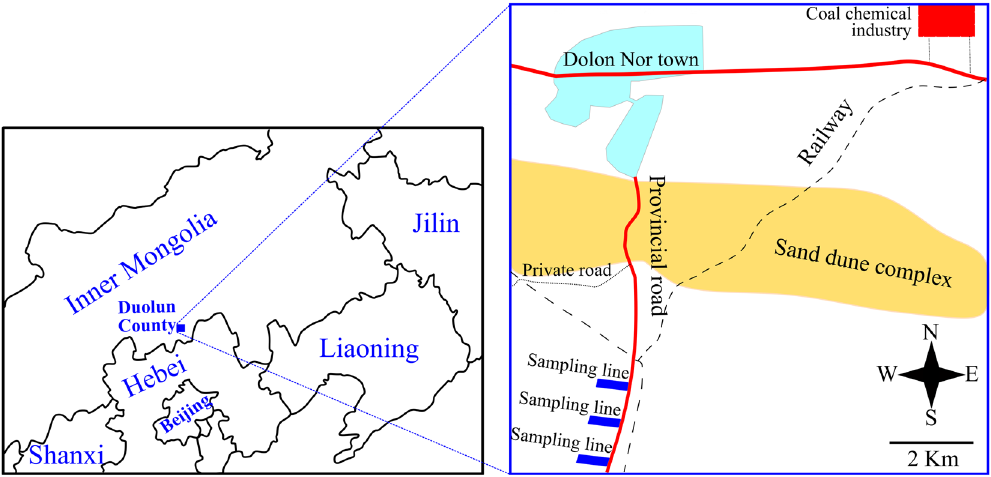
Figure 1. Diagrams showing the location of Duolun County in 2011, and sampling lines. The diagrams were prepared using Inkscape software 0.91 (Free Software Foundation Inc., USA;